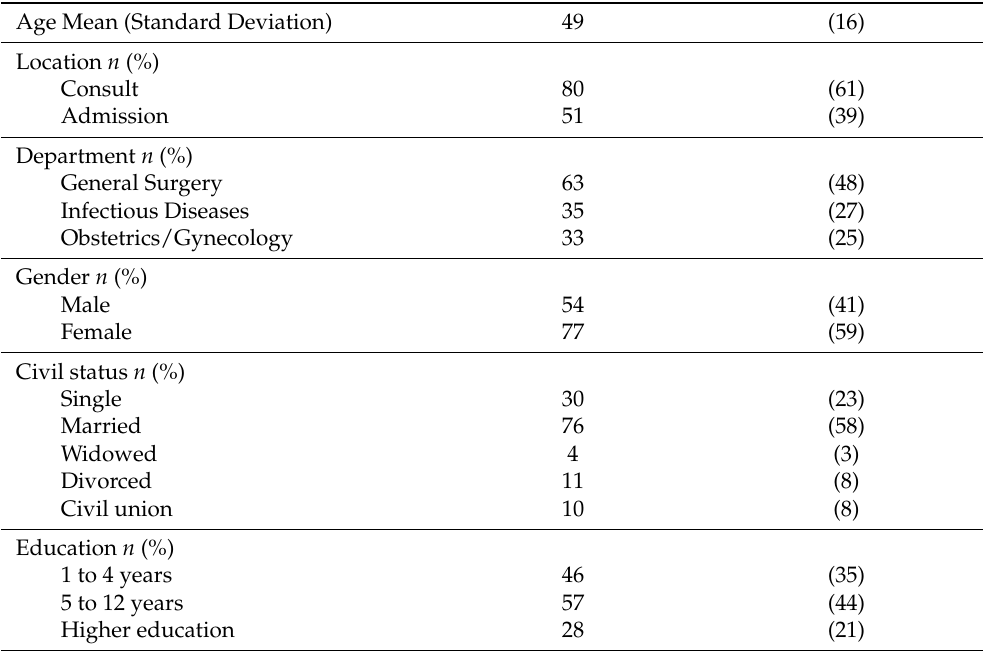
Table 1. Sociodemographic and other characteristics of the study population ( n =